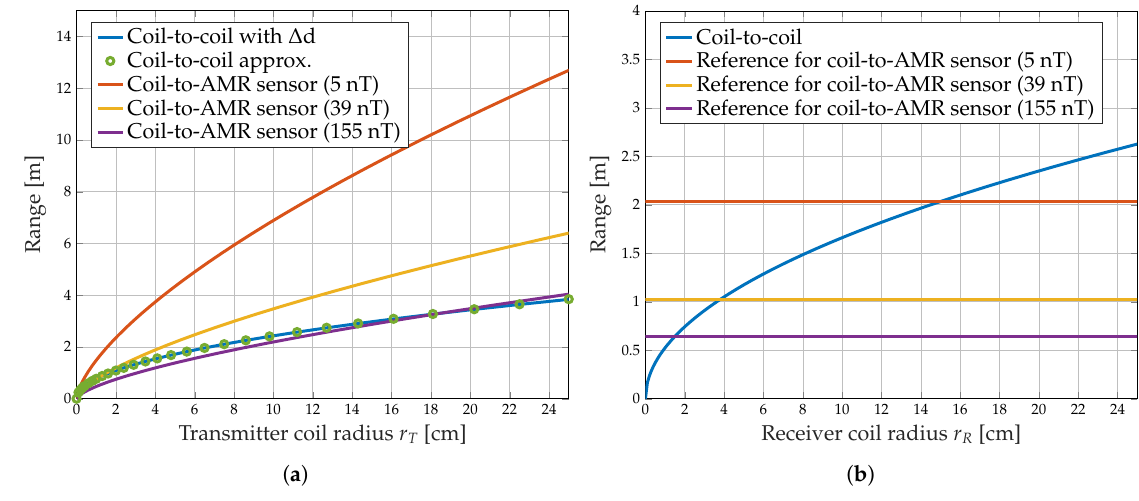
Figure 5. Transmission range for coil-to-coil and coil-to-AMR communication depending on the transmitter coil radius ( a ) and receiver coil radius ( b ). Parameters are taken from Table